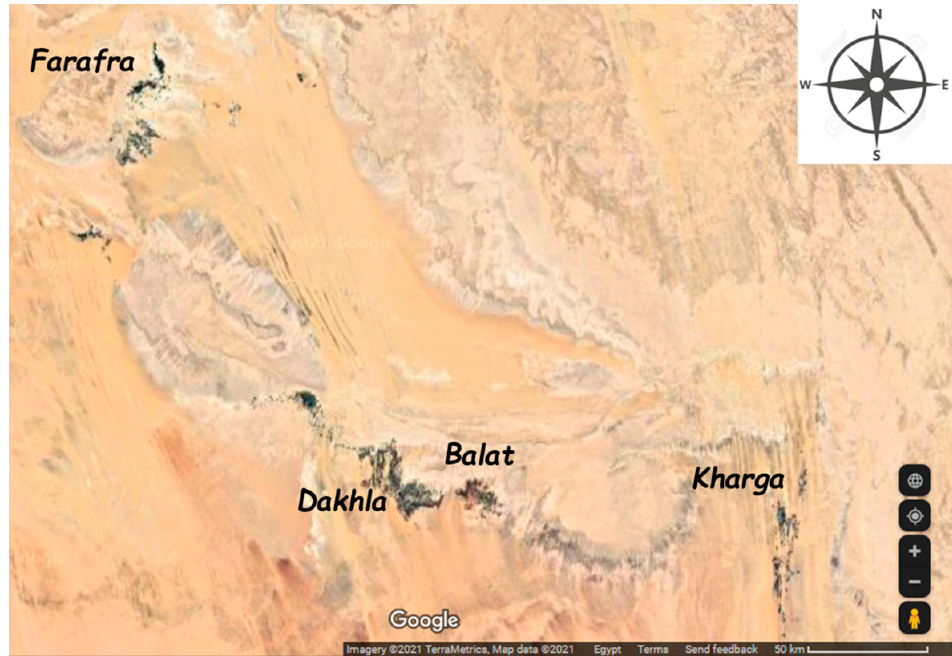
Figure 1. Location map of New Valley Governorate, Egypt showing the study areas of El Kharga oasis (25.4390° N, 30.5586° E), El Dakhla oasis (25.5167° N, 29.1667° E) Balat area (25.560742° N, 29.265589° E), and Farafra oasis (27.0567° N, 27.9703° E). Photo credits: GoogleMaps™ (below the map).